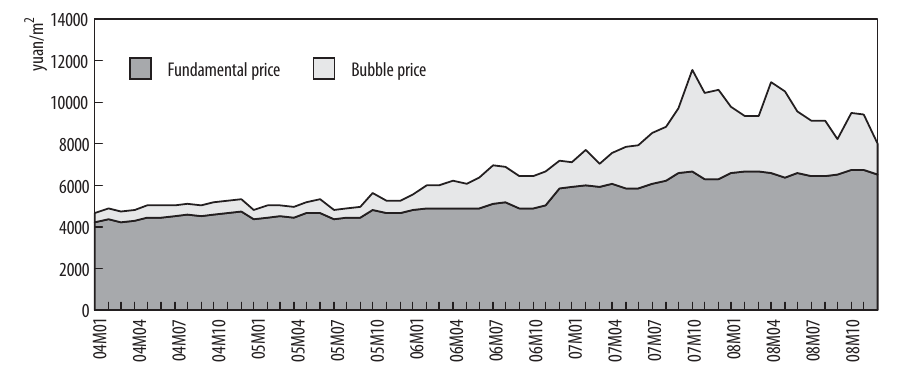
Figure 6. Trend of bubble price and house